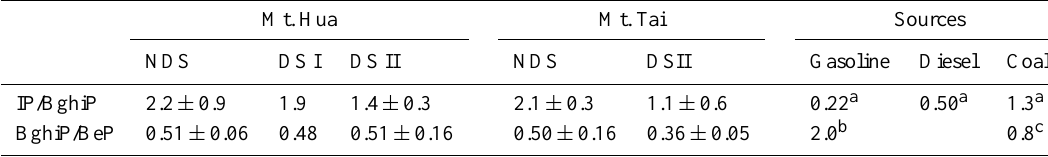
Table 2. Diagnostic ratio of PAHs in the PM 10 collected at Mt. Hua and Mt. Tai. Mt. Hua Mt. Tai Sources NDS DS I DS II NDS DSII Gasoline Diesel Coal IP/BghiP 2.2 ± 0.9 BghiP/BeP 0.51 ± 0.06